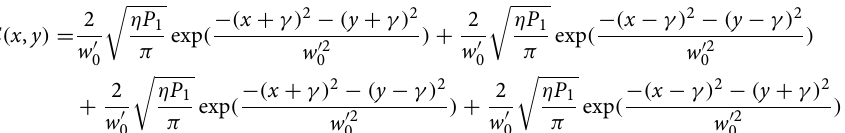
Figure 5. ( a ) The calculated displacement, rotation, velocity and travelled distance of a 2 parabolic metasail with d p initial displacement of (cid:31) x scenario for a dual-pattern sail with initial tilt of �θ y